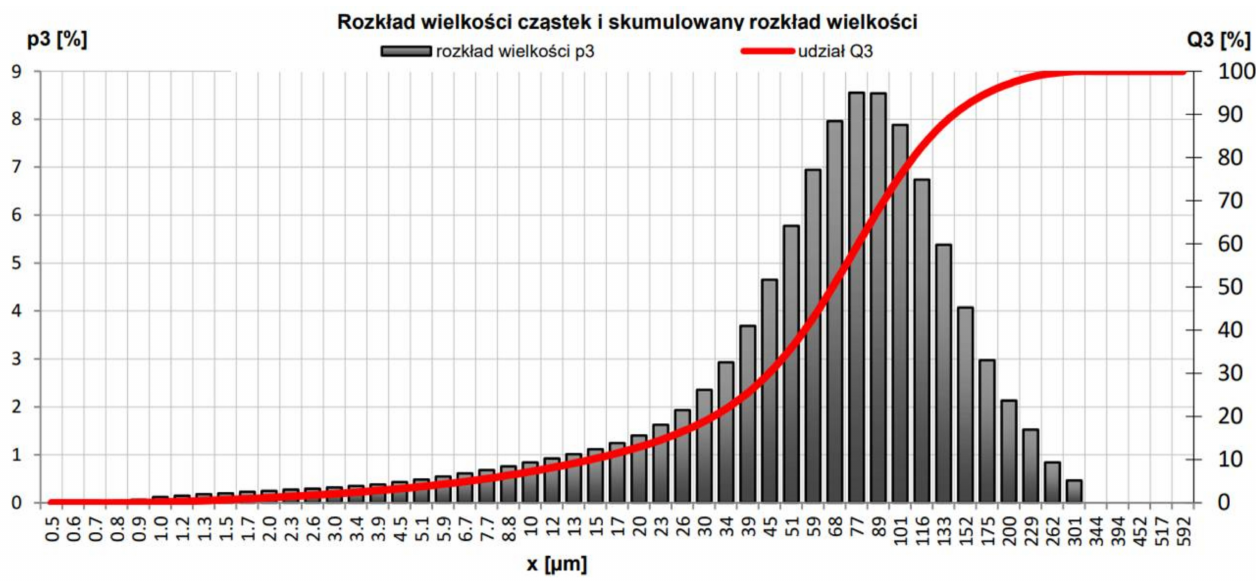
Figure 8. Particle size distribution and cumulative size distribution of